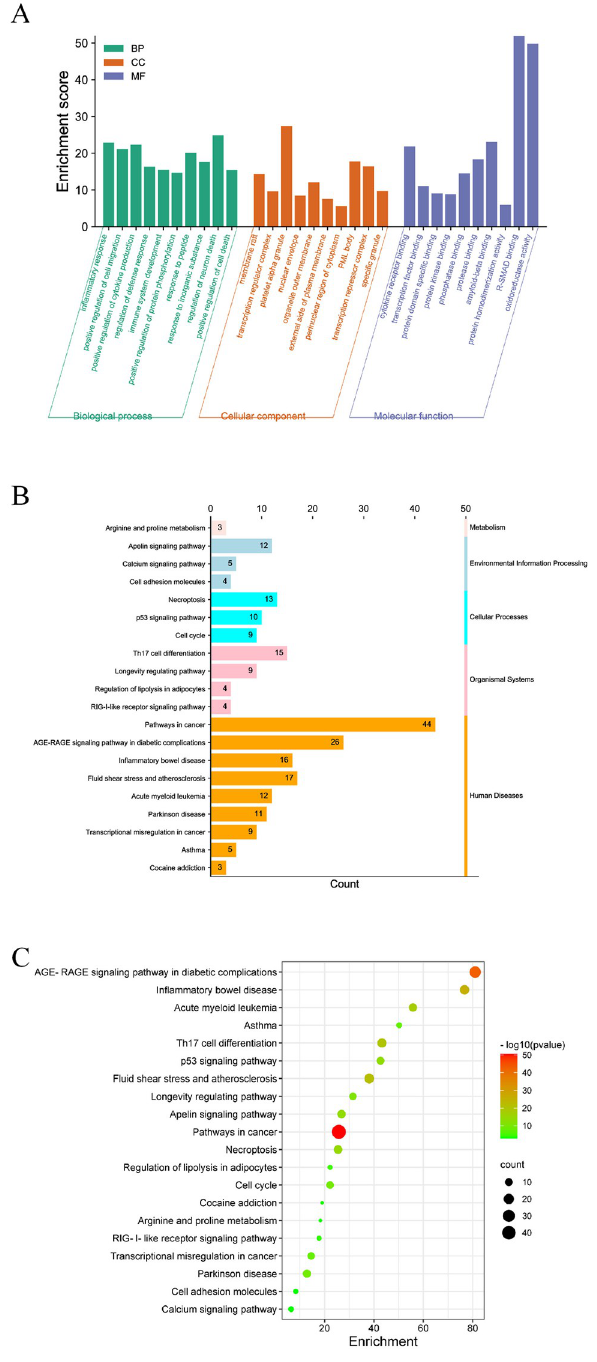
Fig 3. (A) Histogram of GO functional enrichment analysis. (B) Classification diagram for the top 20 KEGG pathways. (C) Bubble Diagram of KEGG enrichment for the top 20